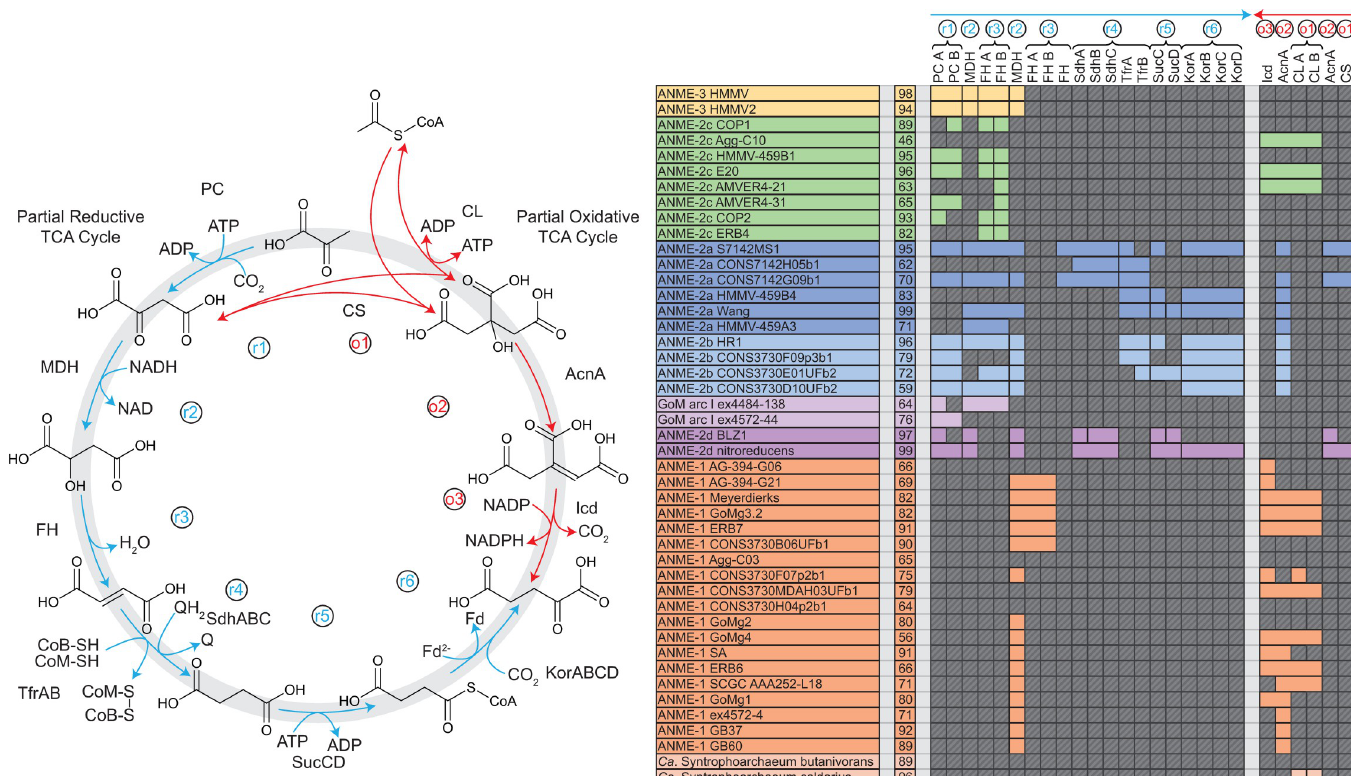
Fig 14. TCA cycle gene present in ANME archaea. ( A ) Schematic of the enzymes and reactants in the partial oxidative and reductive TCA cycles in ANME that lead to 2-oxoglutarate for the purpose of producing anabolic intermediates for biosynthesis. Reductive pathway shown in blue; oxidative pathway shown in red. ( B ) Colored boxes represent presence of various TCA cycle genes in ANME genomes. Missing genes are represented by gray boxes with diagonal line fill. Numbers in the second column represent genome completeness. When genes are together in a gene cluster, their boxes are displayed fused together. Note: Some steps can be carried out by multiple different enzyme systems. Gene accession numbers can be found in S2 Data . ANME, anaerobic methanotrophic; TCA, tricarboxylic acid.